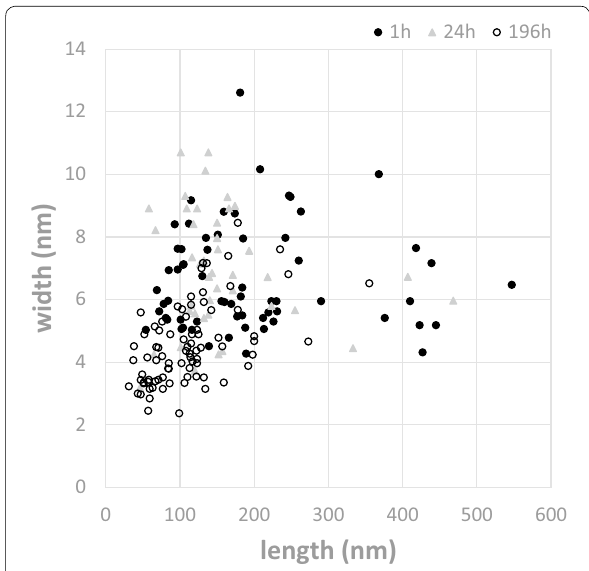
Fig. 4 Lengths and widths of saccharified cellulose residues. Filled black circles are data for cellulose saccharified for 1 h, filled gray circles are data for cellulose saccharified for 24 h, and open circles are data for cellulose saccharified for 196 h